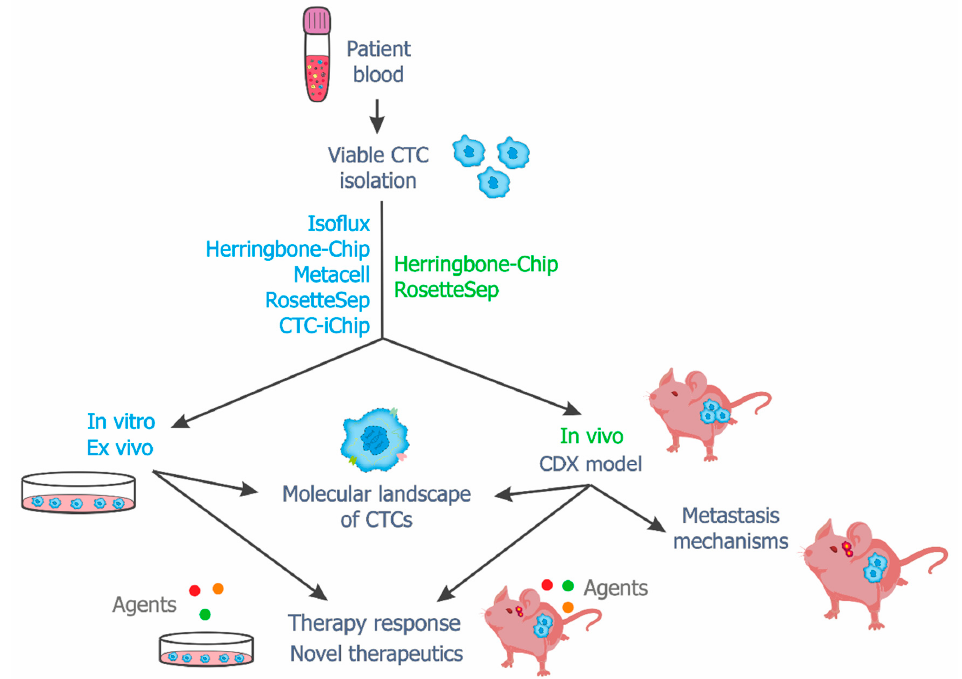
Figure 3. Potential applications of viable CTCs. The figure shows the methods that were efficient in obtaining CTC-derived in vitro, ex vivo and in vivo models. These models can be used for molecular analysis, drug response testing, the development of new therapeutics, and the investigation of metastasis mechanisms.